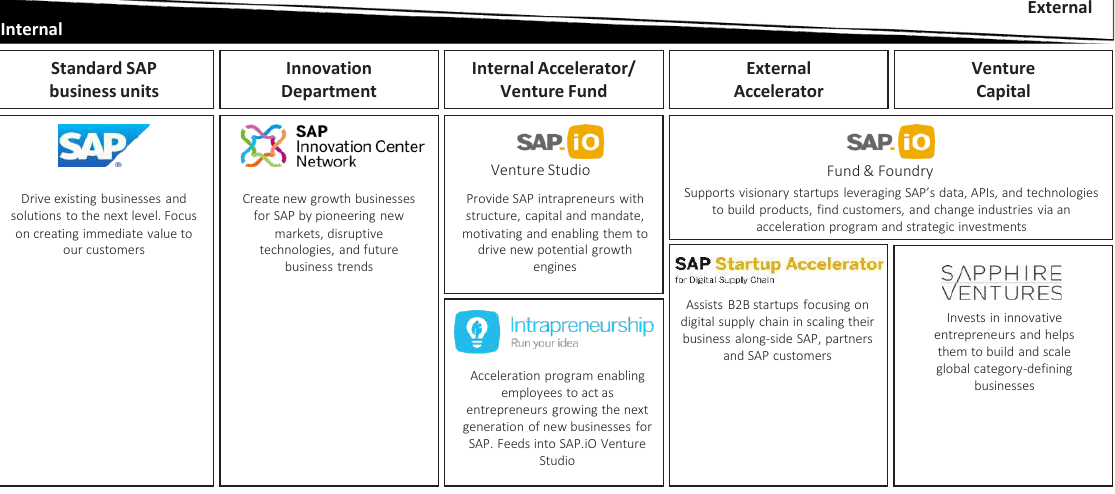
Figure 1. Different innovation, incubation and venturing initiatives at